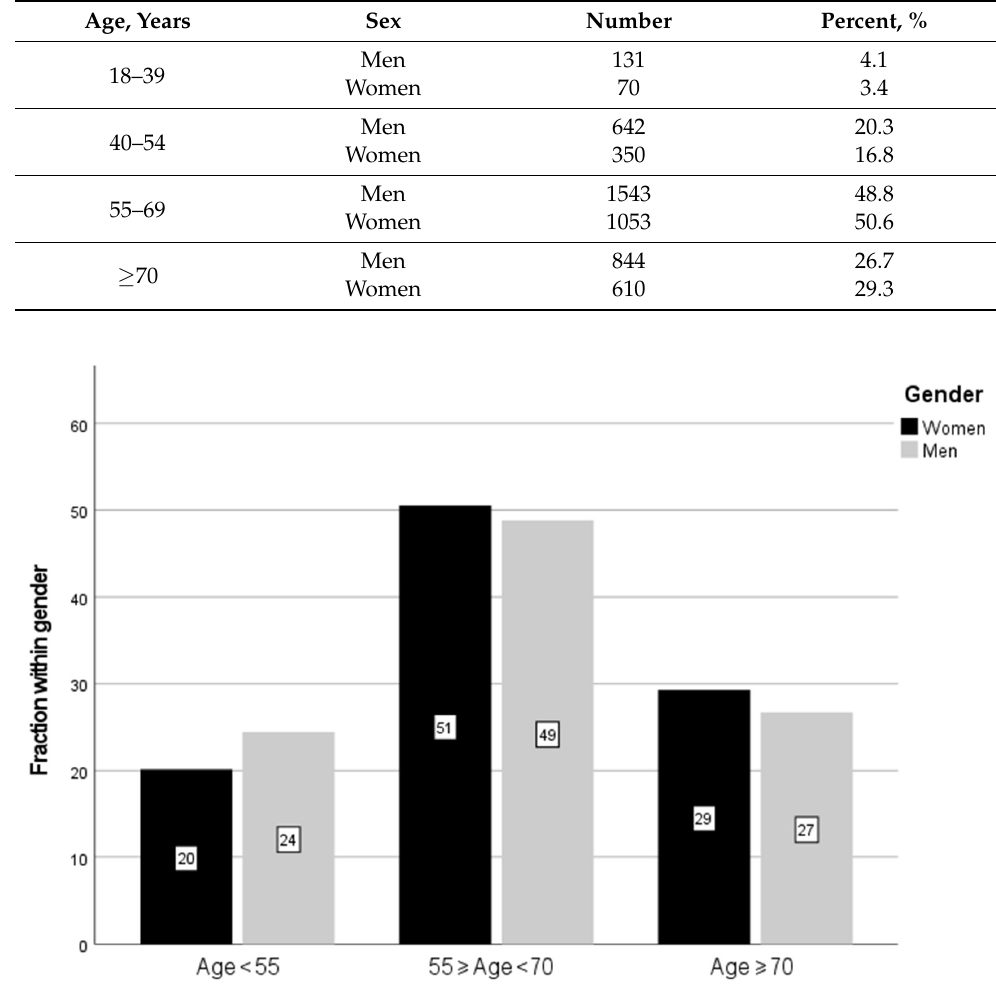
and conversely, less men were reported with PPS 2, 3 and 4, with these sex differences being significant ( p < 0.001) (Figure 2.)